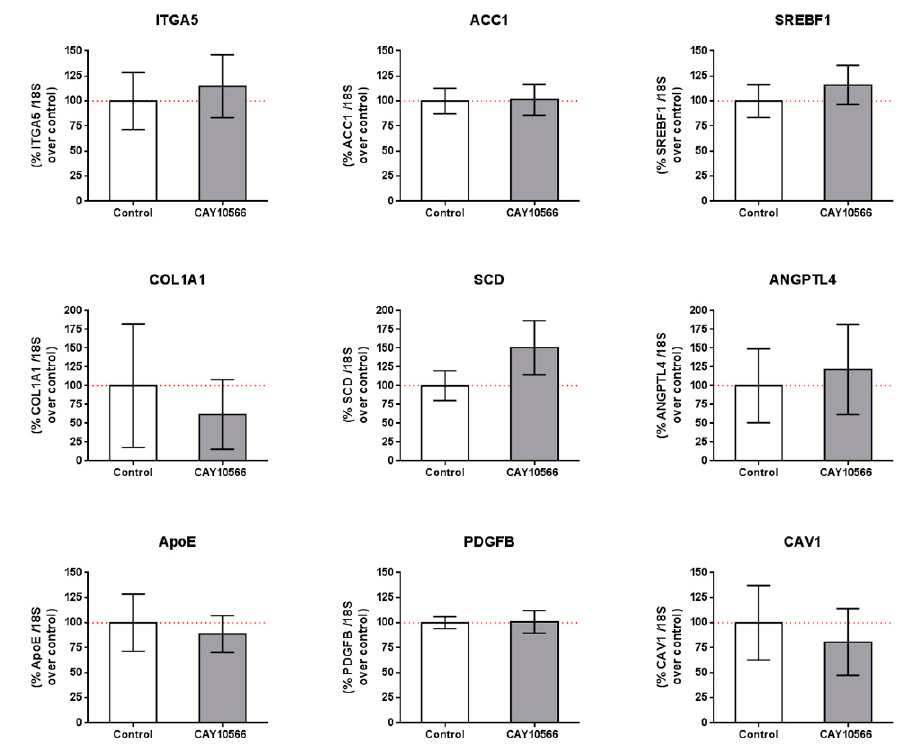
Figure 5. Gene expression in mRPE cells after 100 nM CAY10566 treatment for 24 h. A broad panel of genes related to cell adhesion, extracellular matrix, lipid synthesis and metabolism and cell signaling was checked. Data represent mean ± SEM gene expression with respect to the 18S-housekeeping gene of three different experiments. The Wilcoxon non-parametric test was used to evaluate related samples. The red dashed line is a guidance mark for 100% expression in control cells.